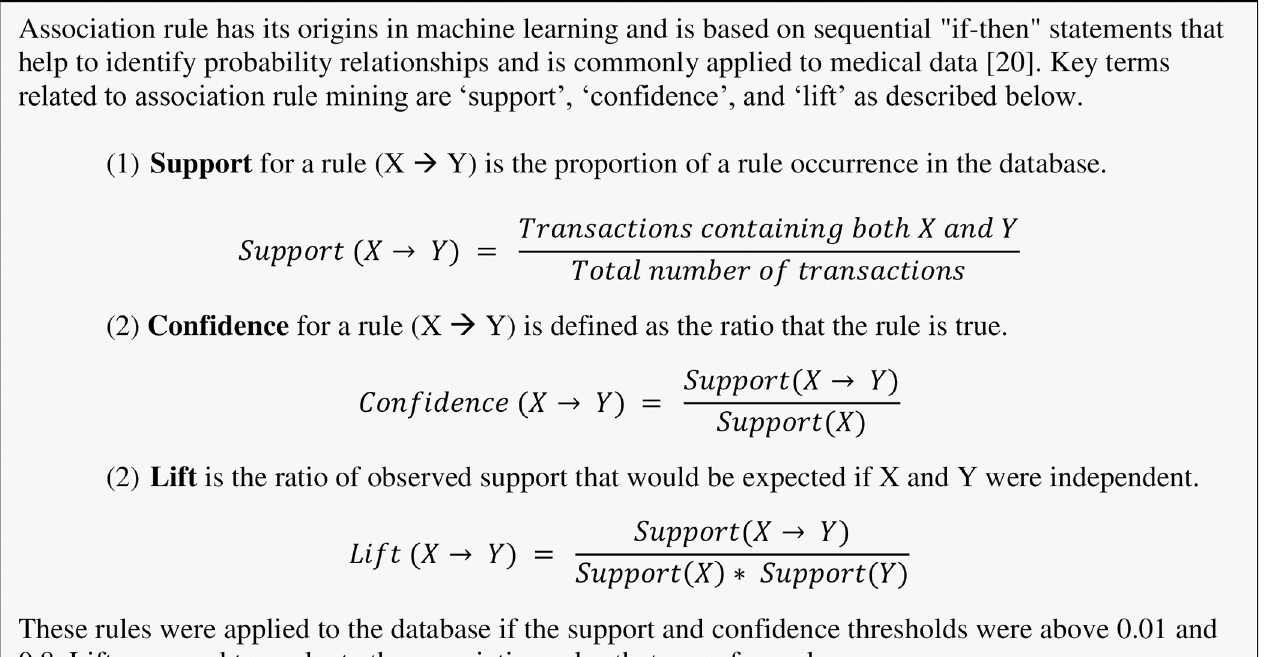
Fig 2. Fundamentals of association rule